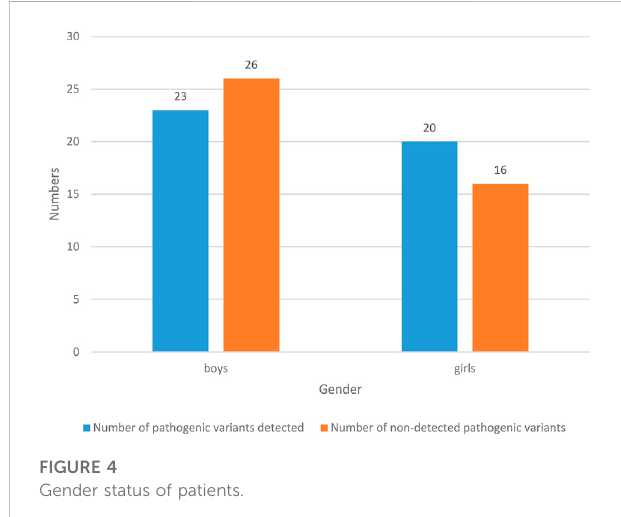
FIGURE 4 Gender status of patients.